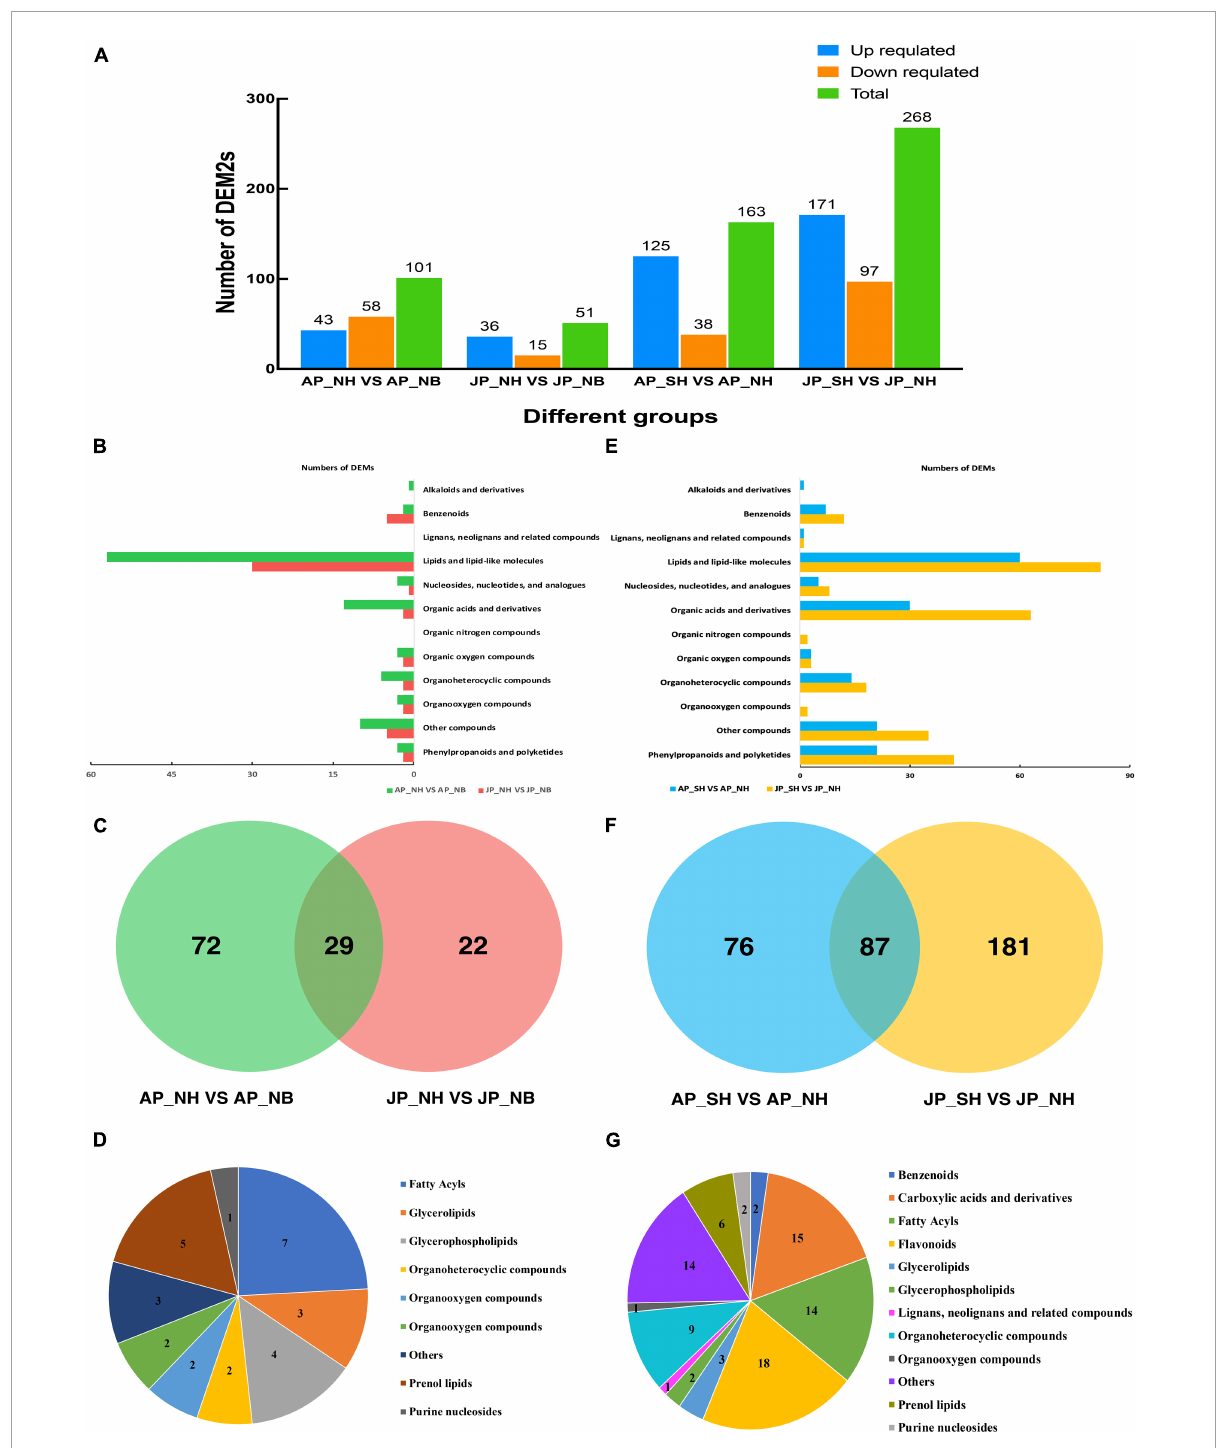
FIGURE3 Analysis of differentially expressed metabolites. (A) Number of DEMs in different comparison groups. (B) The type and quantity of differential metabolites in NH and NB comparison groups under two environments. (C) Venn diagram of differential cumulative metabolites in NH and NB comparison group. (D) Types and quantities of differential metabolites shared by NH and NB comparison groups. (E) The type and quantity of differential metabolites in SH and NH comparison groups under two environments. (F) Venn diagram of differential cumulative metabolites in SH and NH comparison group. (G) Types and quantities of differential metabolites shared by SH and NH comparison